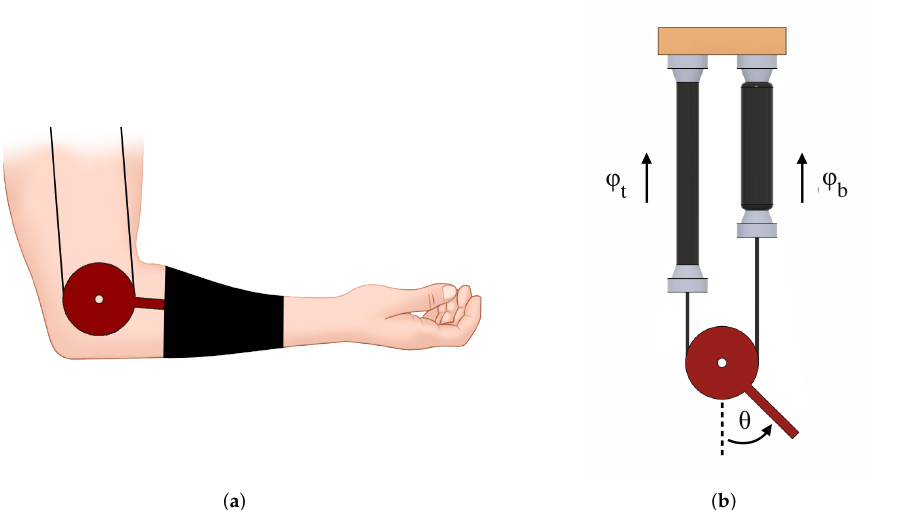
Figure 3. ( a ) Pulley at the elbow joint. ( b ) Antagonistic scheme of PAMs connected to the